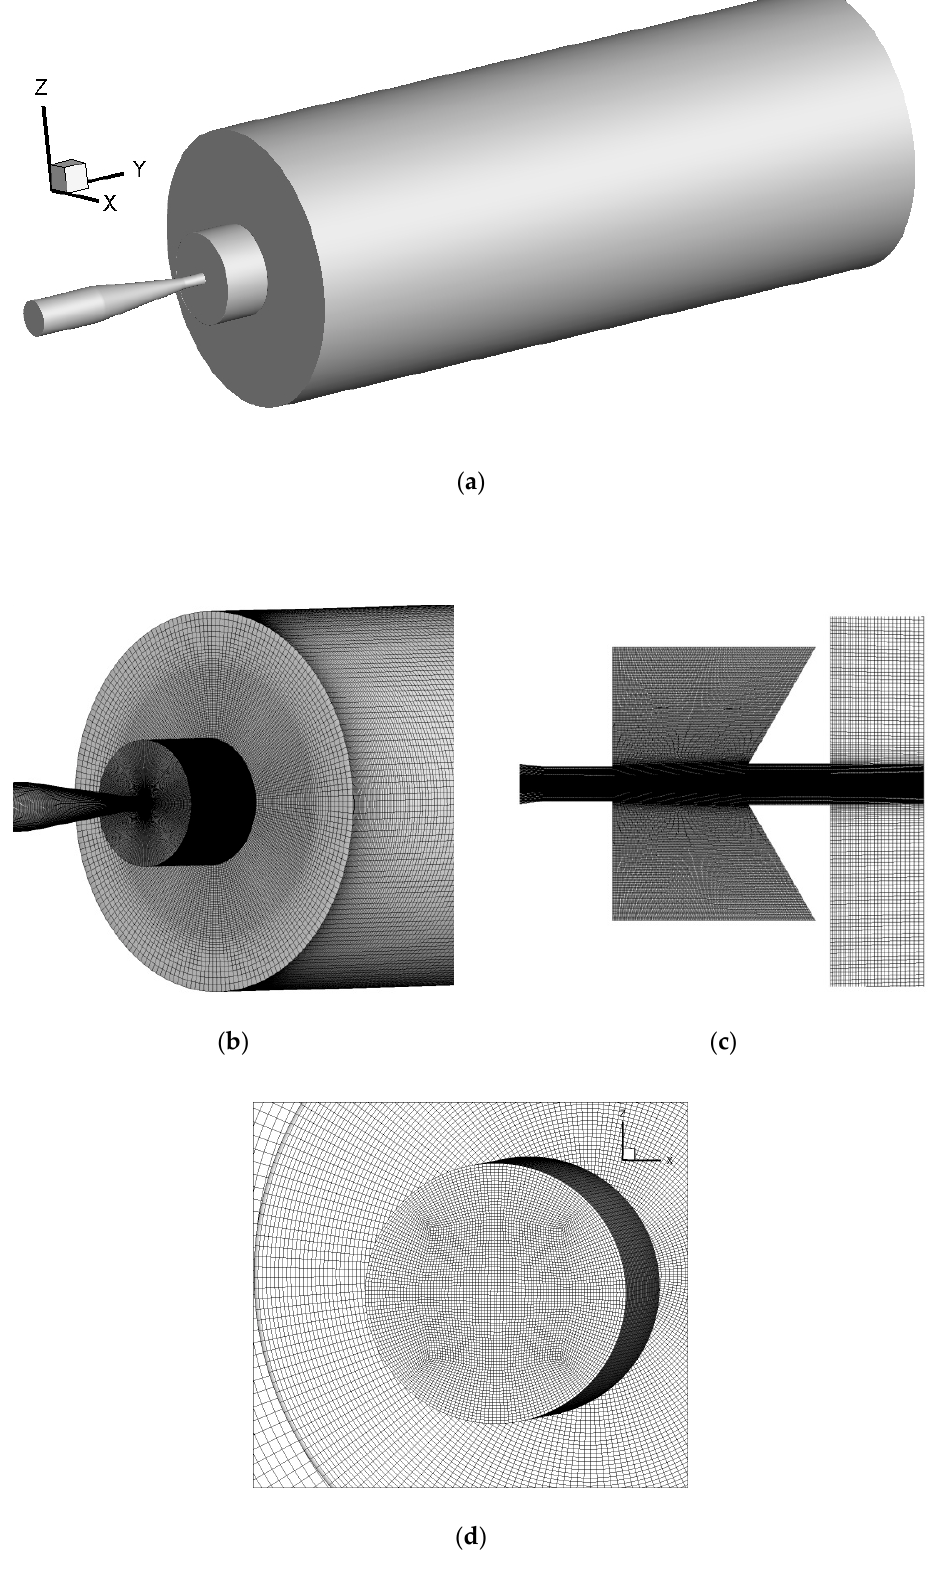
Figure 3. ( a ) Schematic view of computational domain; ( b ) grid of computational domain; ( c ) grid of cross-section; ( d ) O-grid around the axis.